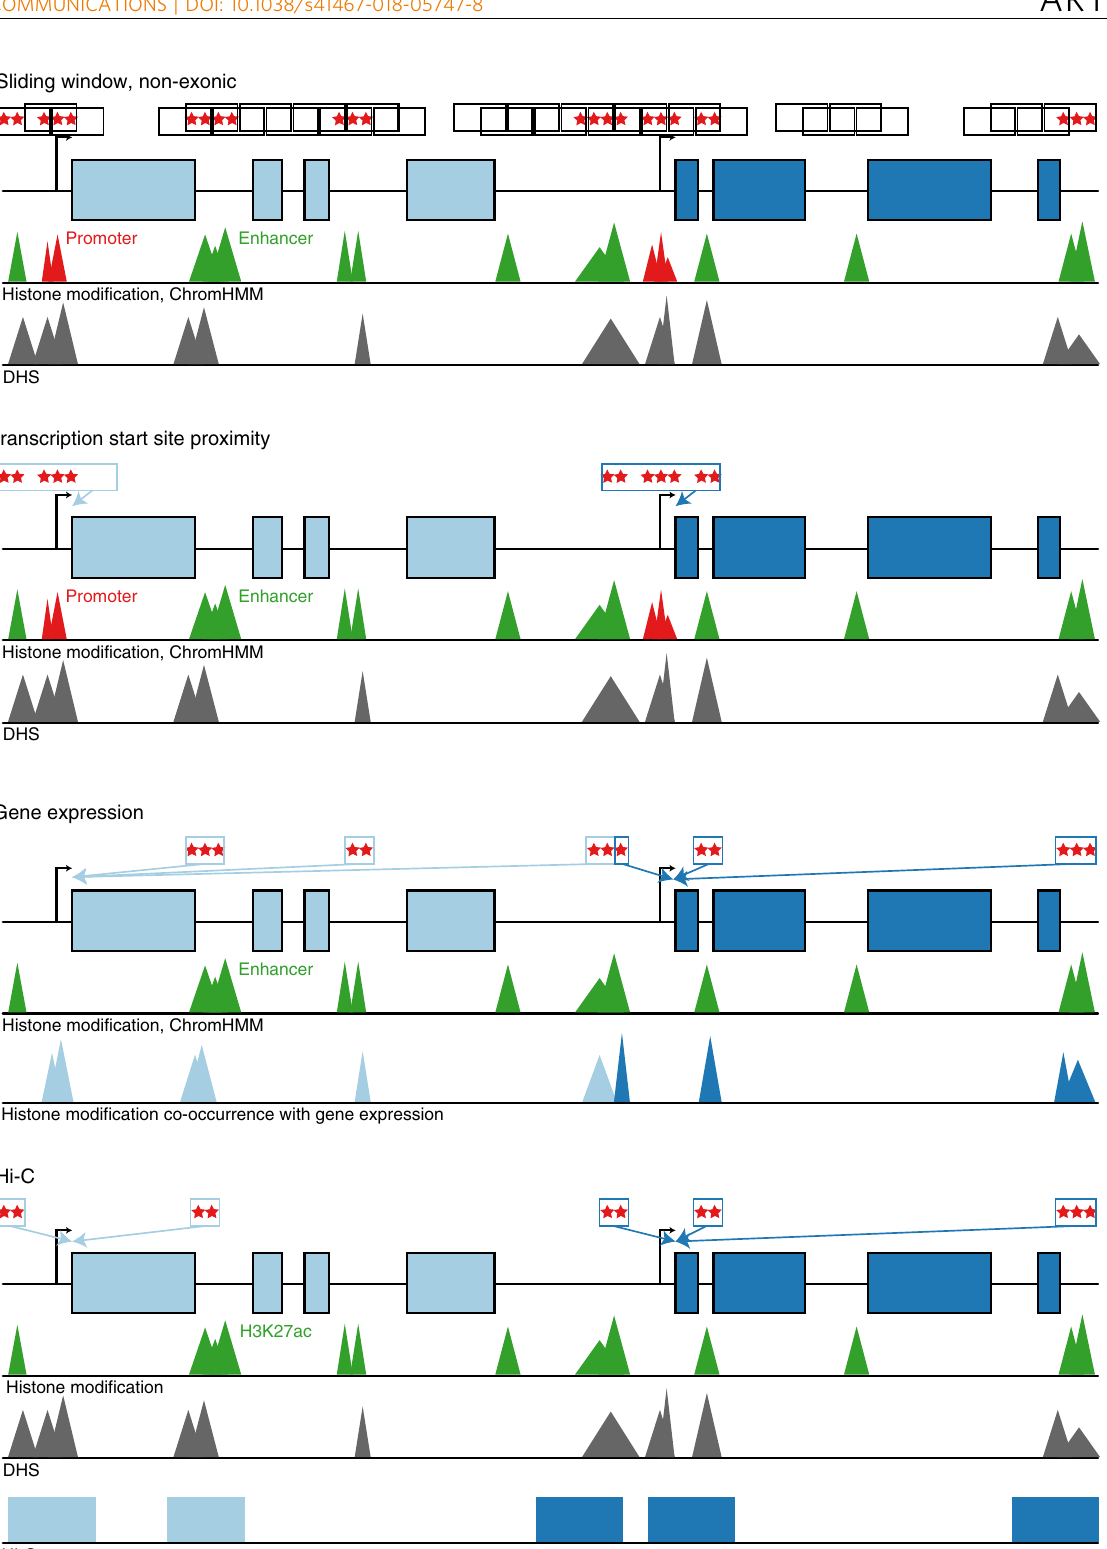
Fig. 3 Schematic of non-coding rare variant analyses. Four grouping schematics of rare non-coding variants (MAF <1%). (1) The sliding window approach tiles across the genome at fi xed widths, only including variants overlying annotations consistent with enhancers, promoters, and DHS in non-exonic regions. All other approaches attempt to map non-coding putative functional genomic regions with discrete genes as the analytical unit. Overall, they are based on: (2) promoter, enhancer, and DHS annotations near a gene ’ s transcription start site, (3) co-occurrence of enhancer and DHS annotations with HepG2 gene expression, and (4) H3K27ac marks within Hi-C contact regions mapped to genes. DHS DNase hypersensitivity site, MAF minor allele